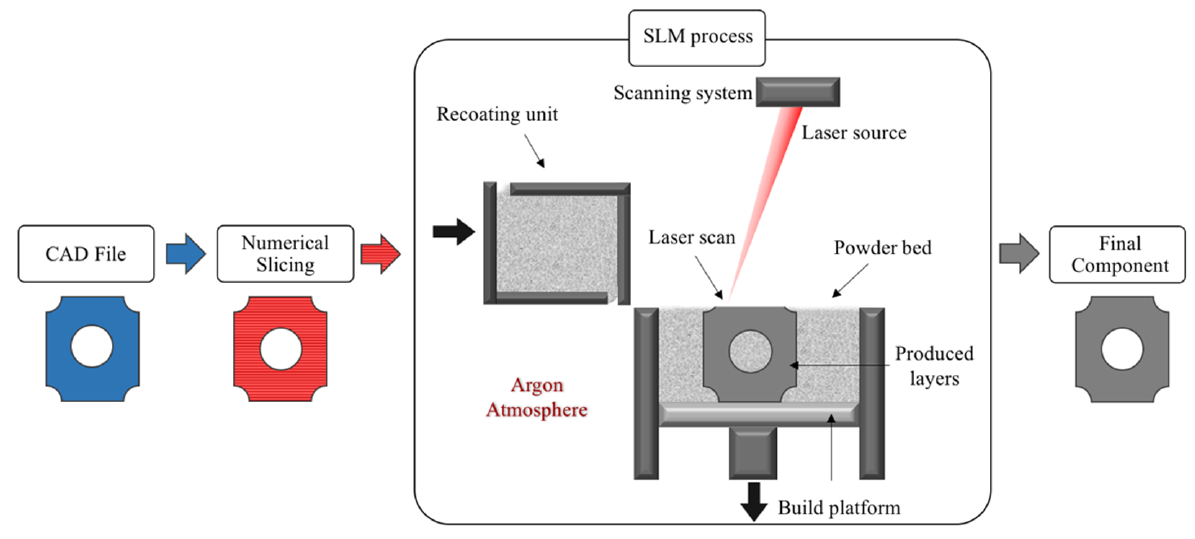
Figure 3. Schematic representation of Laser Powder Bed Fusion technology. Table 2. Summary of studies addressing Ti6Al4V parts produced by